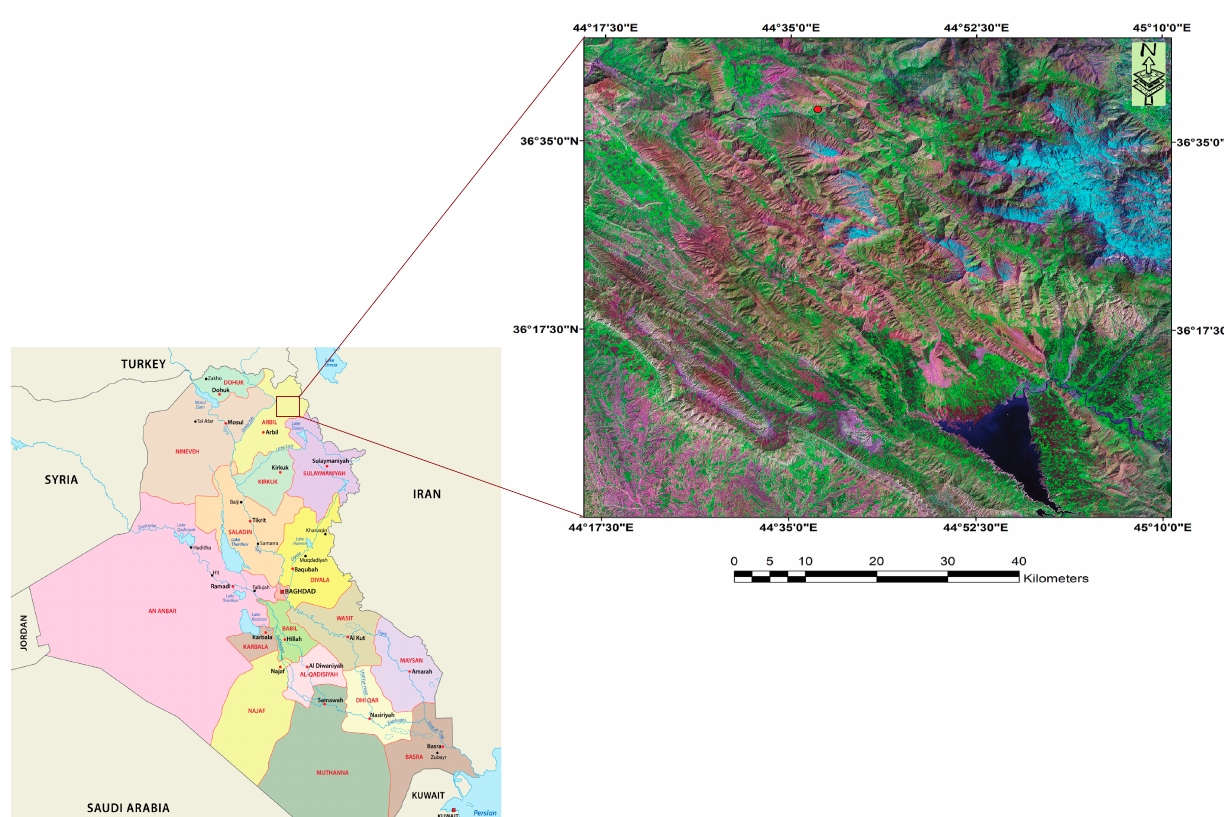
Figure 1. General map illustrates the location of the studied area “green